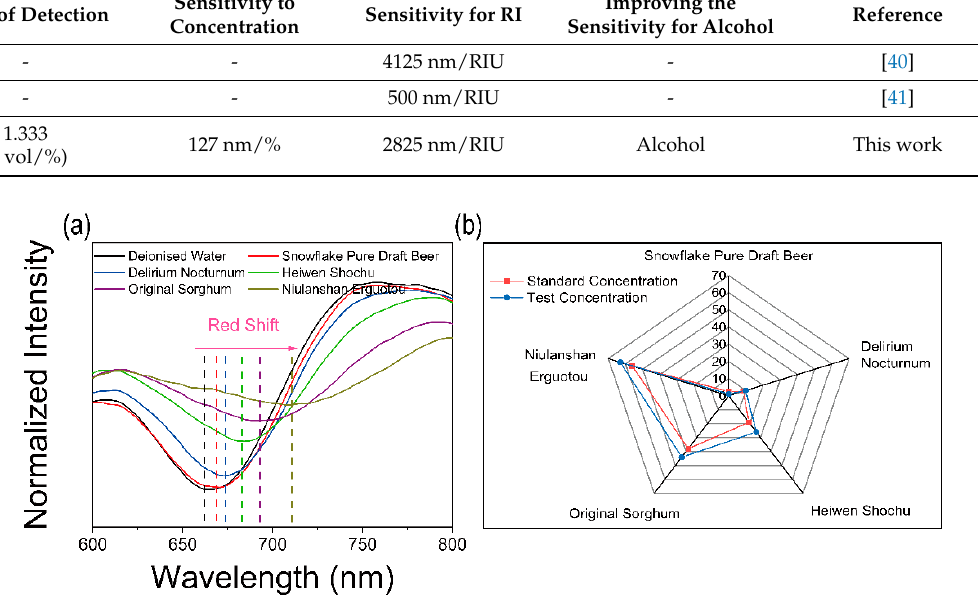
Figure 8. Practical application tests. ( a ) Alcohol sensing test. ( b ) Comparison of test concentration and standard concentration.